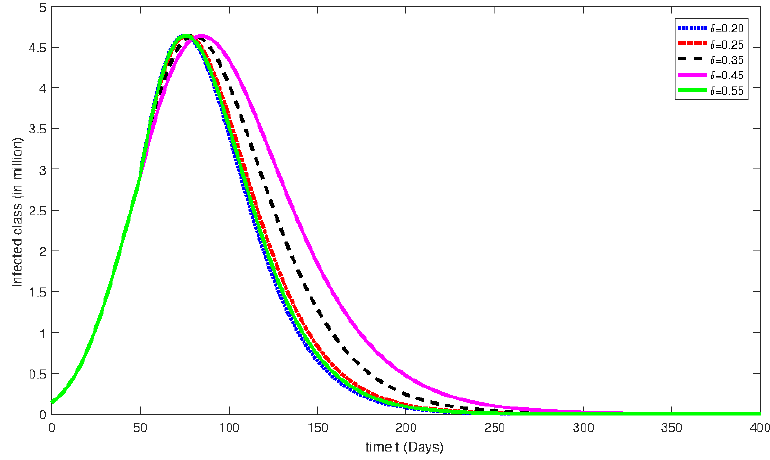
Figure 4. Numerical solution for infected class for the given days and using different fractional orders with isolation rate of